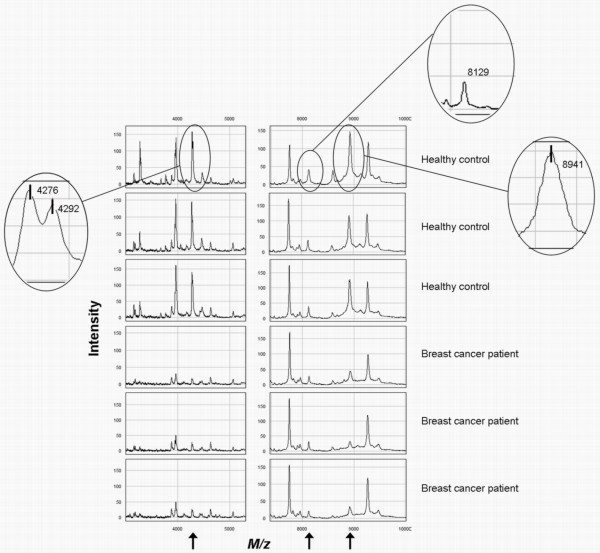
Representative SELDI-TOF MS spectra showing the intensity of the peaks with an m/z of 4276, 4292, 8129 and 8941 in breast cancer cases and healthy controls.